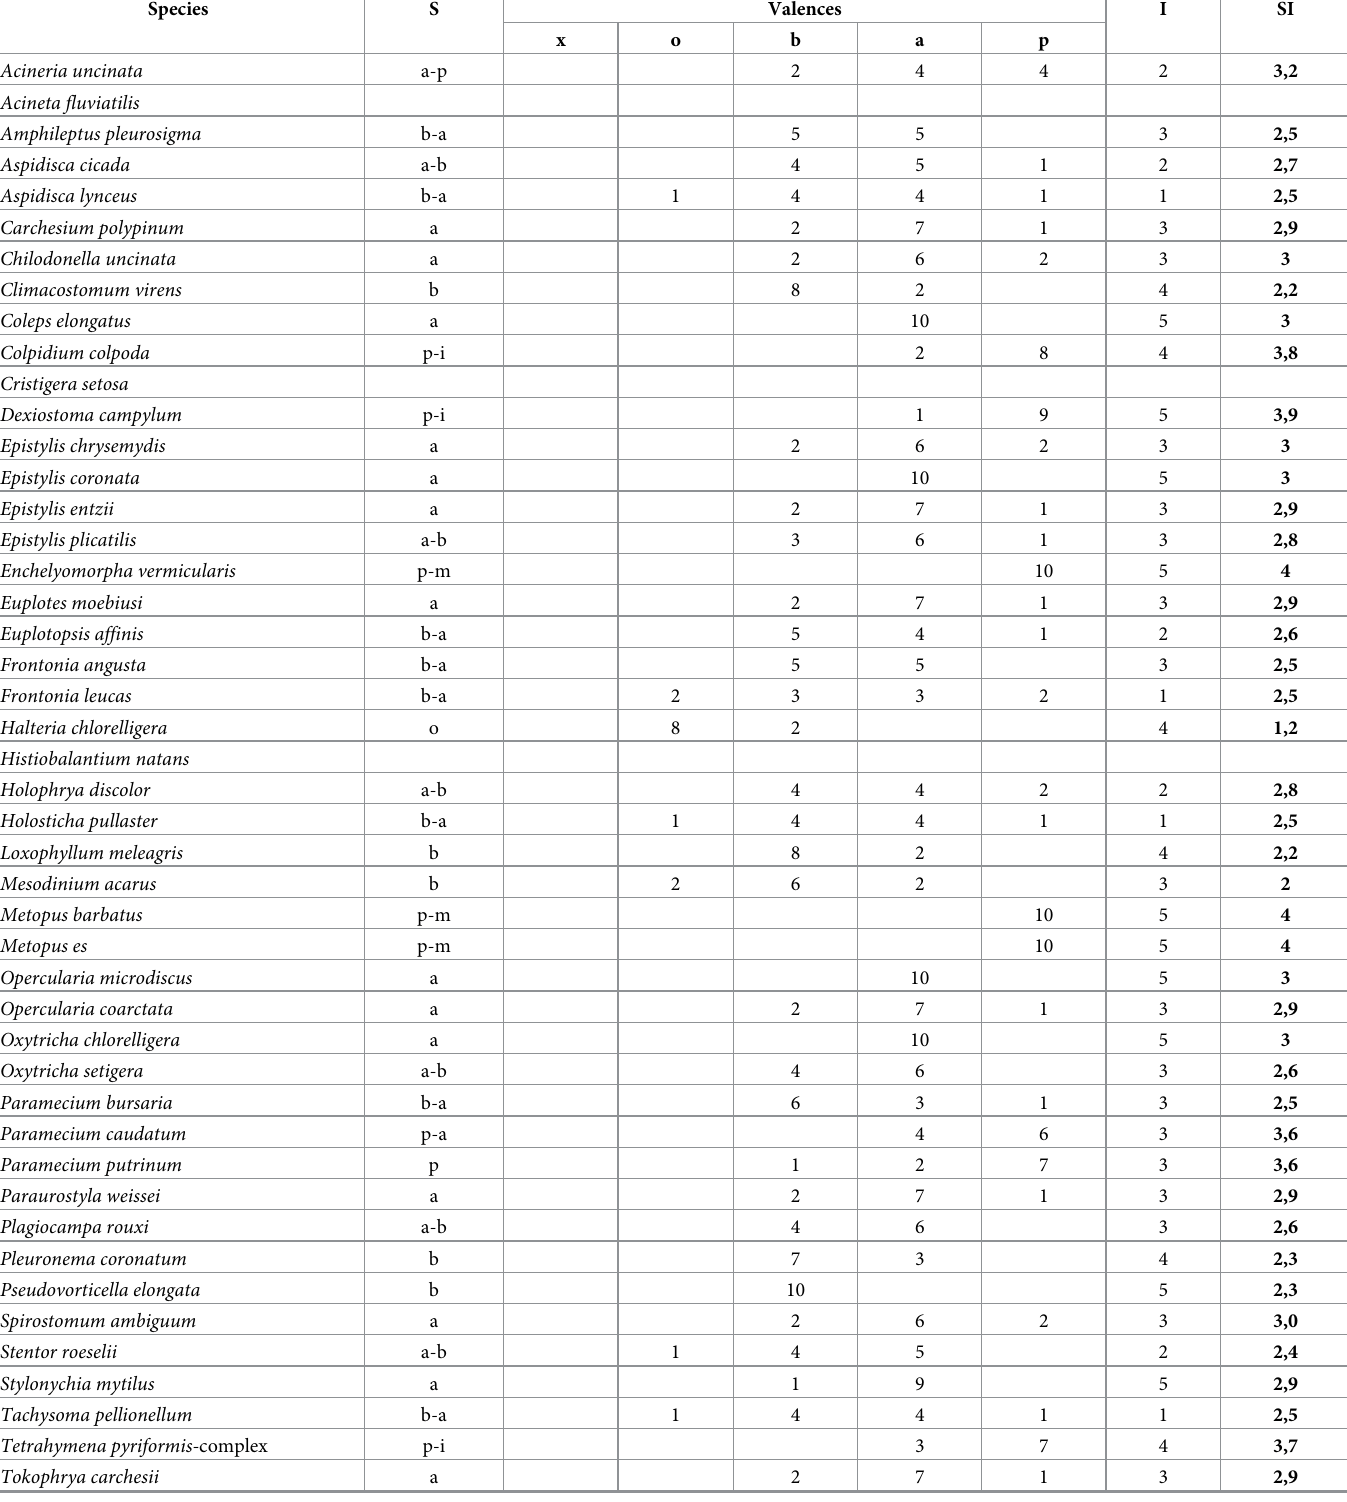
Table 3. List of ciliate species and their saprobic parameters (by [20, 37]) identified in the section of the Uzh river. Species S Valences